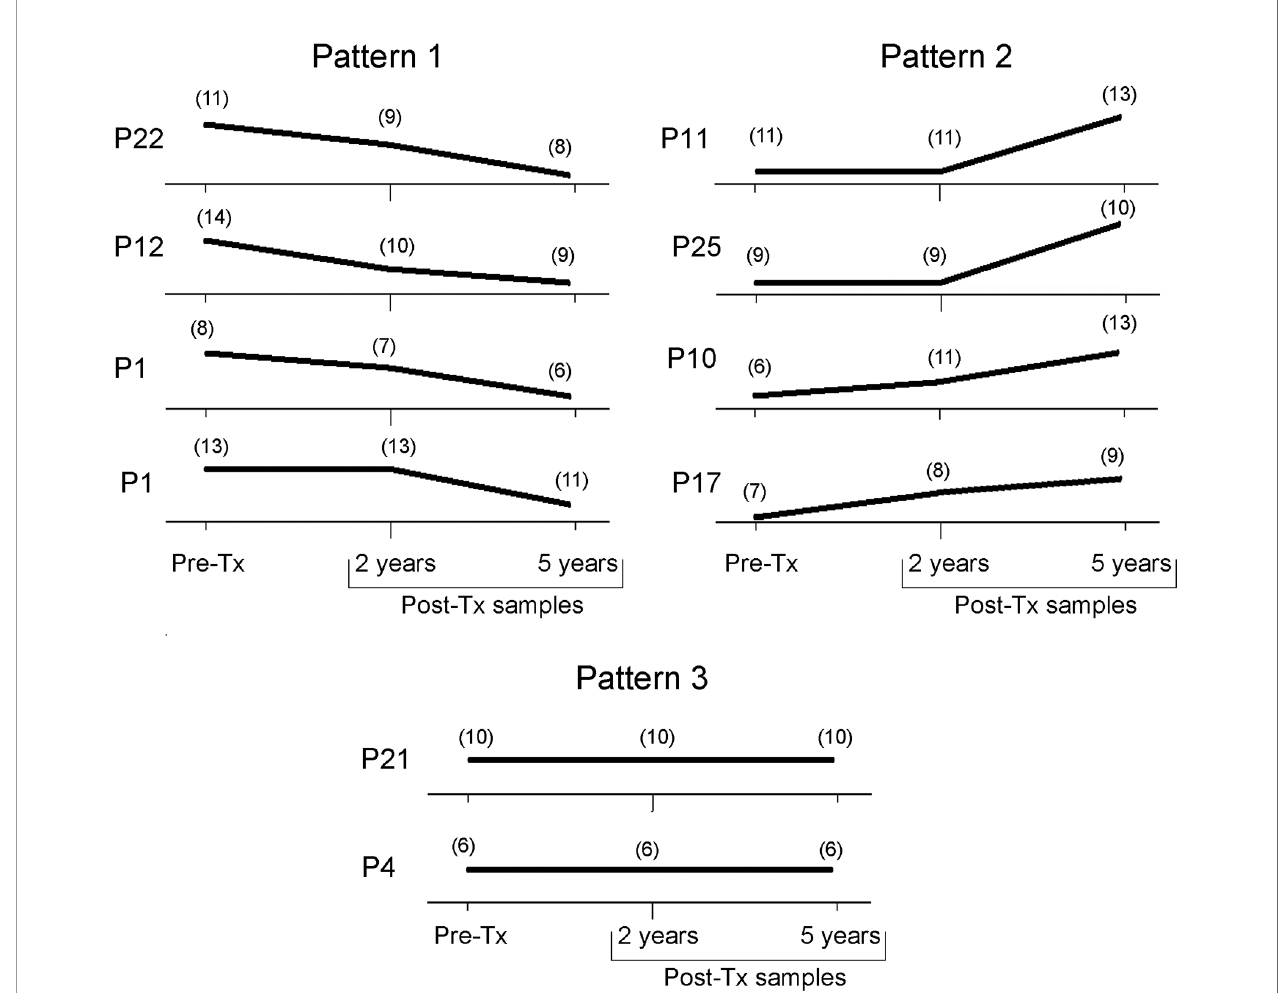
FIGURE 6 | Trend of the genetic variability of natural T. cruzi populations by kDNA-RFLP. Each panel represents the count of the number of bands present at each time point along follow-up. Tx,